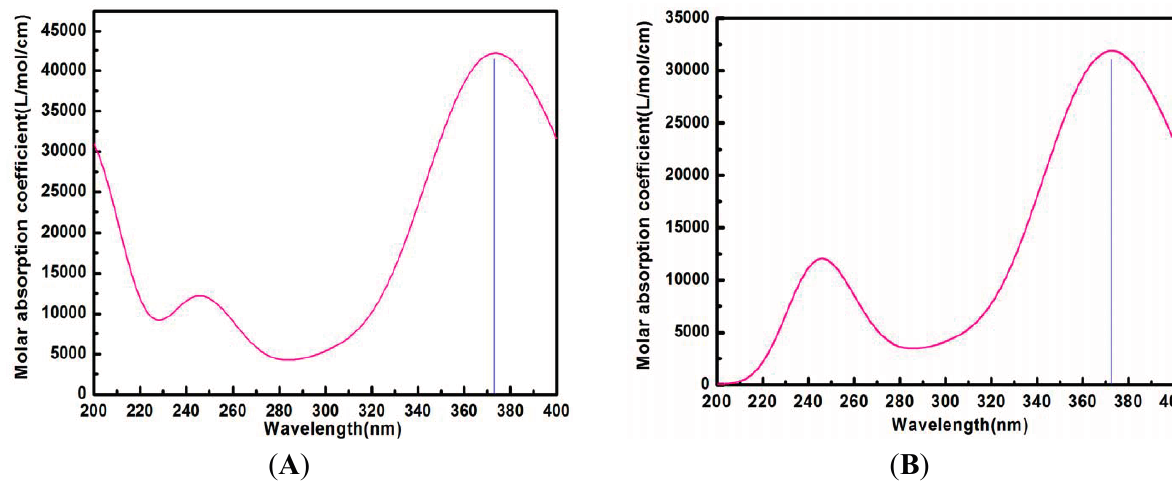
Figure 9. Calculated UV spectra by the B3LYP/6-31+G(d) level of theory. ( A ) ILTG (374 nm); and ( B ) the ILTG/G 2 - β -CD inclusion complex (373